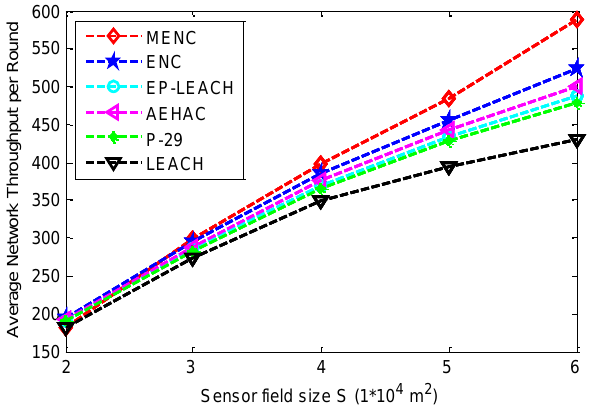
Figure 10. The comparison of ANTR among MENC, ENC, EP-LEACH, AEHAC, P-29 and LEACH for different sensor field sizes.